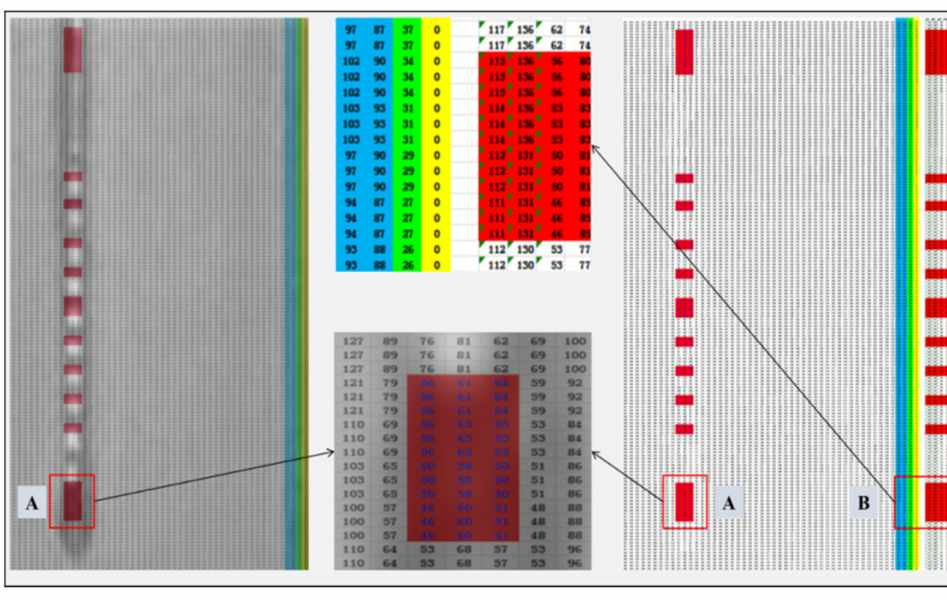
Figure 6. Detection results of the steel strip.